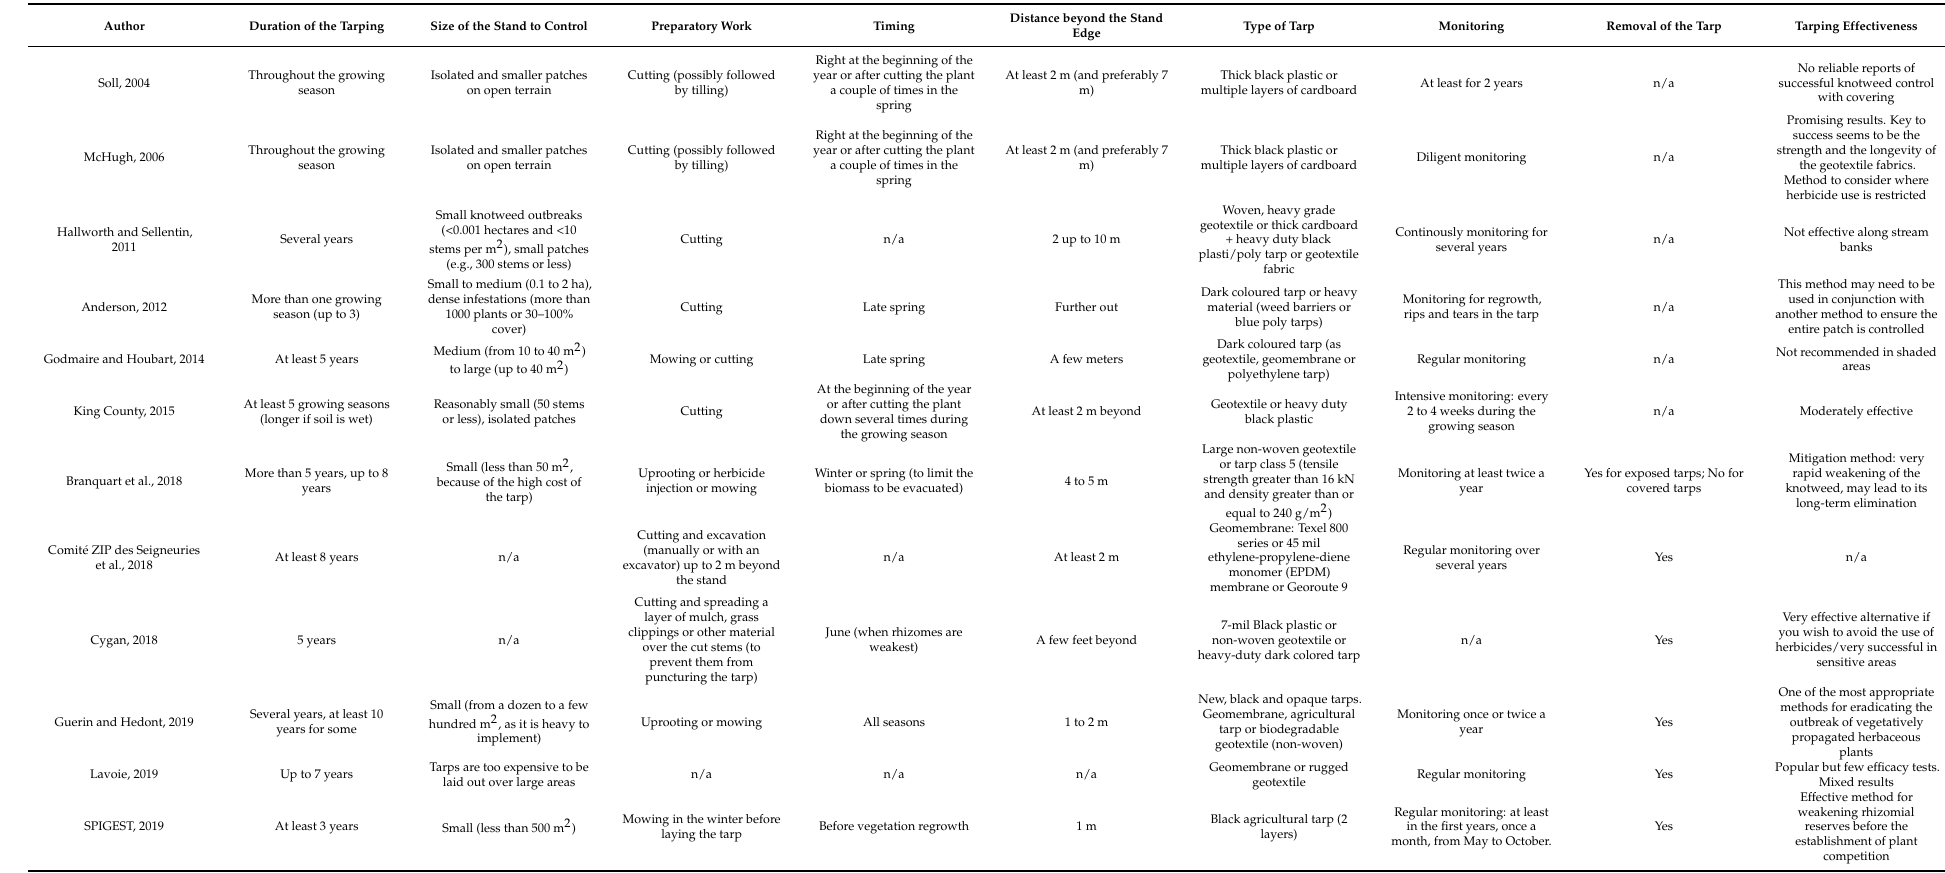
Table 1. Summary of recommendations for the implementation of tarping and comments on its effectiveness. Here we selected the documents from our bibliographical review that we considered to be the most detailed on the tarping